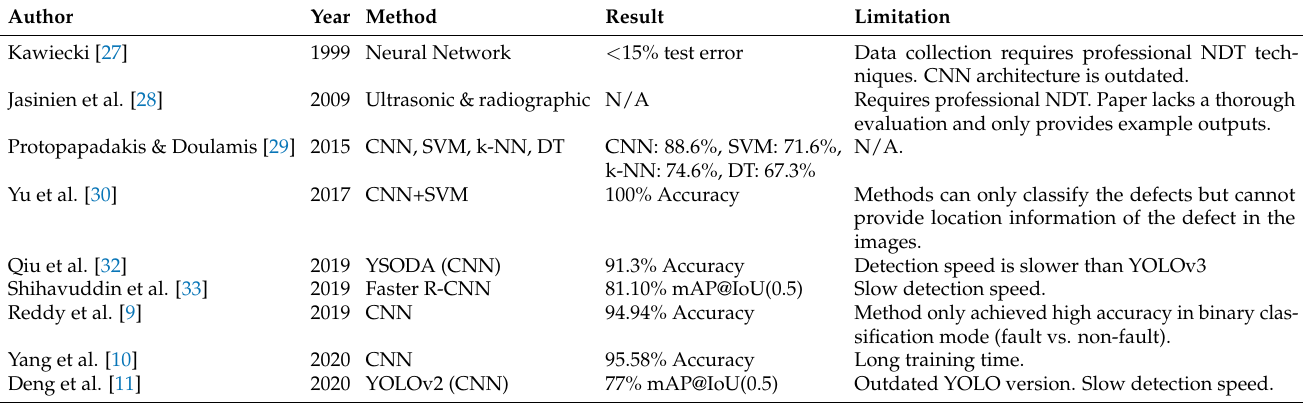
Table 1. Summary of DL and ML techniques for WTB defect detection and classification.